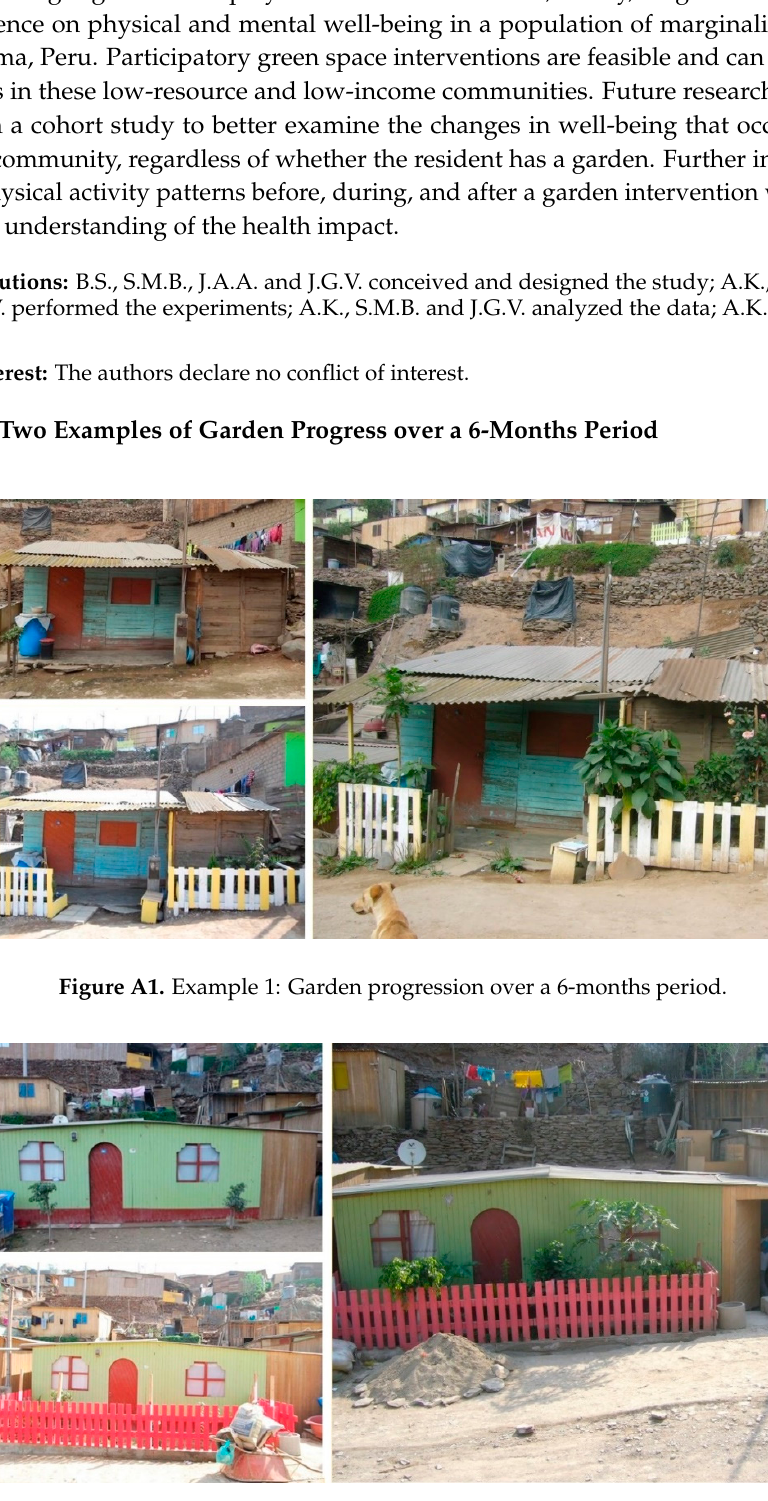
Figure A2. Example 2: Garden progression over a 6 ‐ months period.